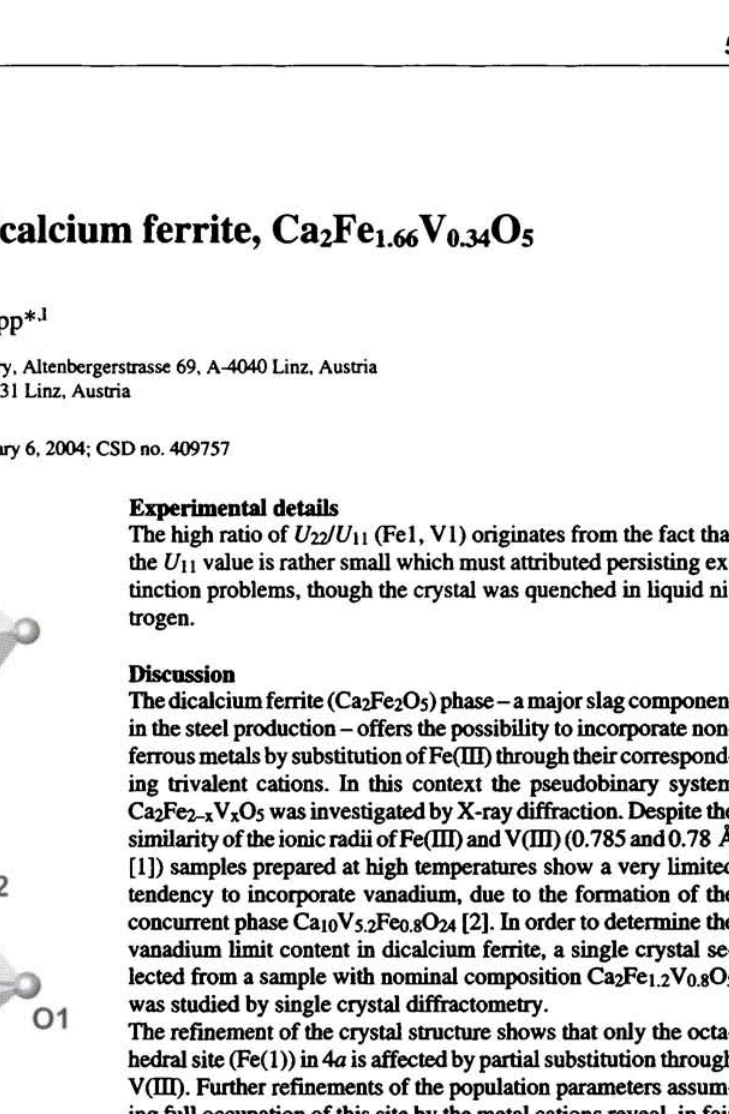
Table 1. Data collection and